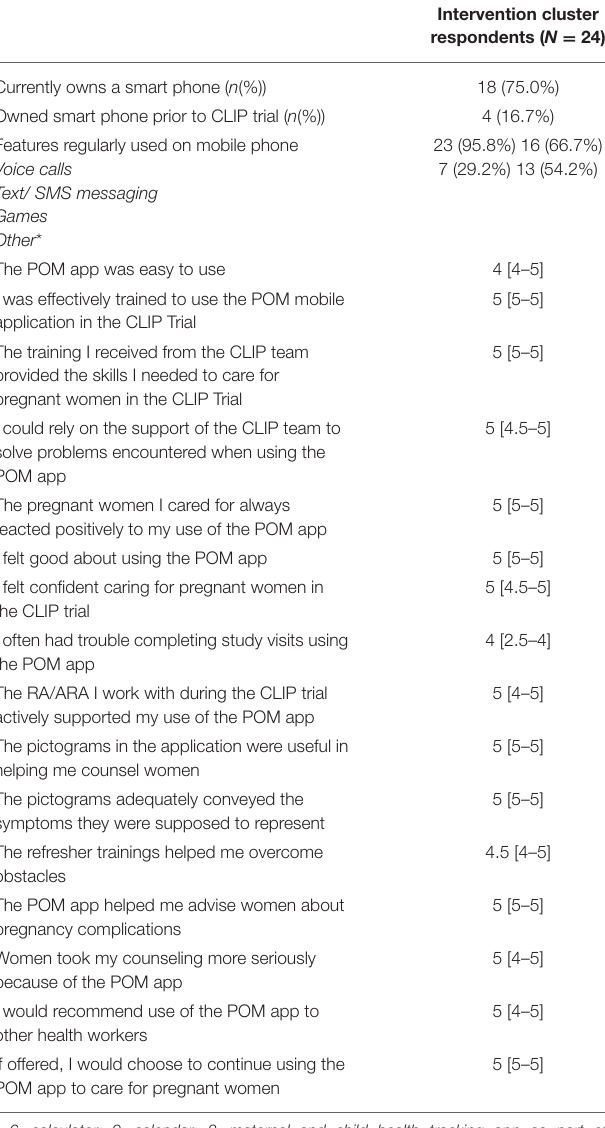
TABLE 3 | Summary of survey responses related to experience with the POM app in the CLIP trial.